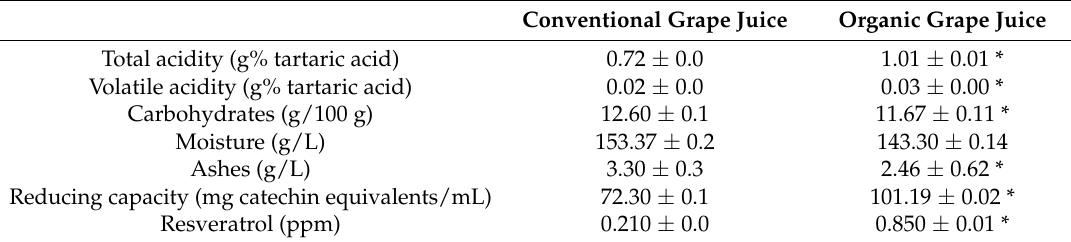
Table 2. Composition of purple grape